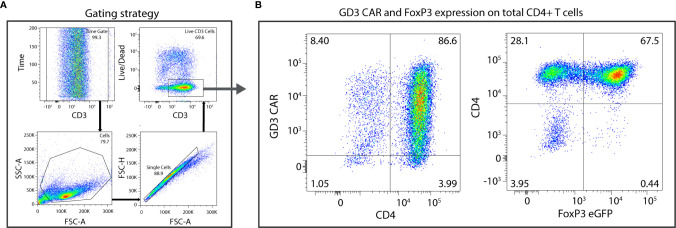
High transduction efficiencies are observed for Tregs expressing the GD3 CAR. CD4+FoxP3+ cells, polarized from naïve CD4+ T cells, were transduced using a GD3 CAR-encoding construct. (A) The gating strategy consists of a time gate followed by sequentially gating on lymphocytes, single cells, and live cells. (B) Eighty-six percent of total CD4+ T cells were successfully transduced to express the GD3 CAR construct and 67% of that population express FoxP3+.